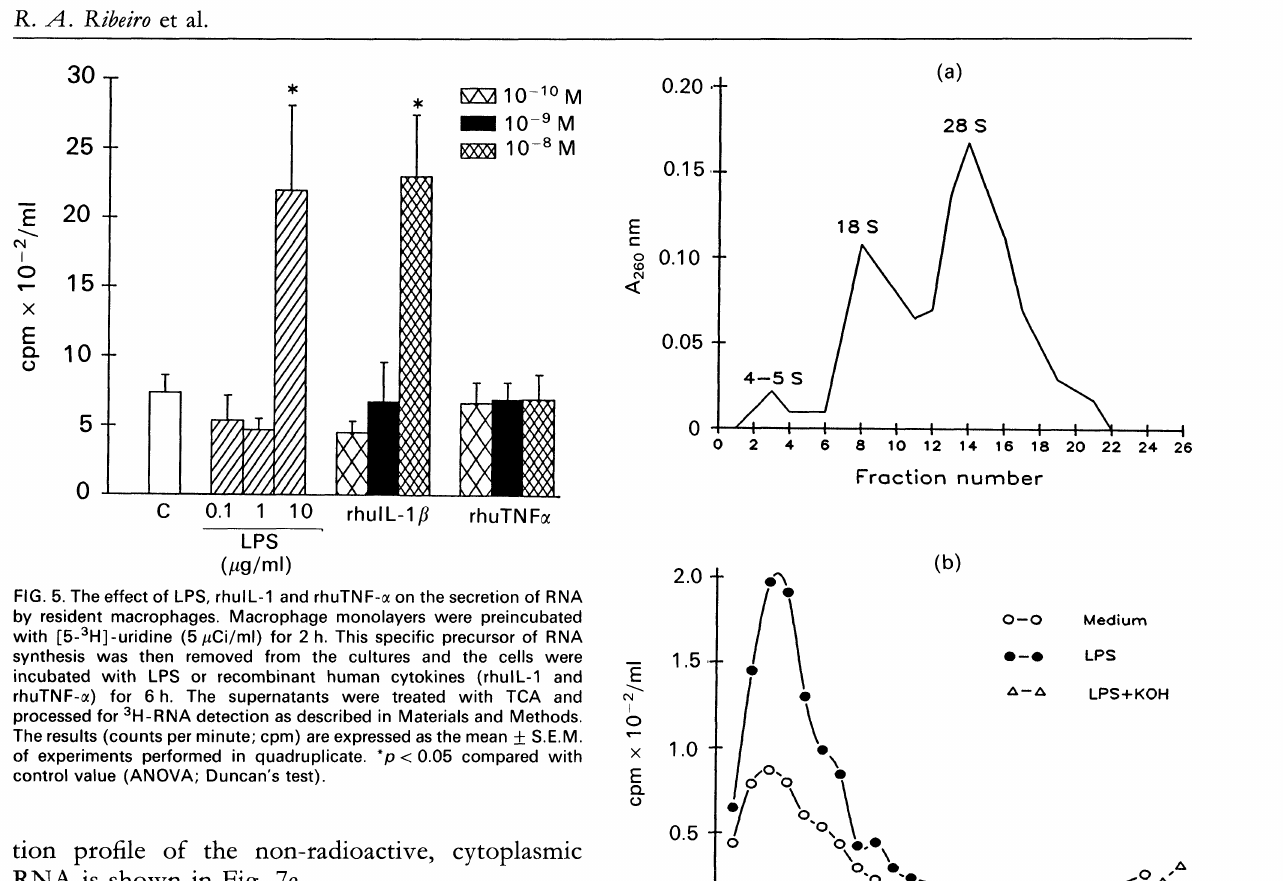
RNA is shown in Fig. 7a.